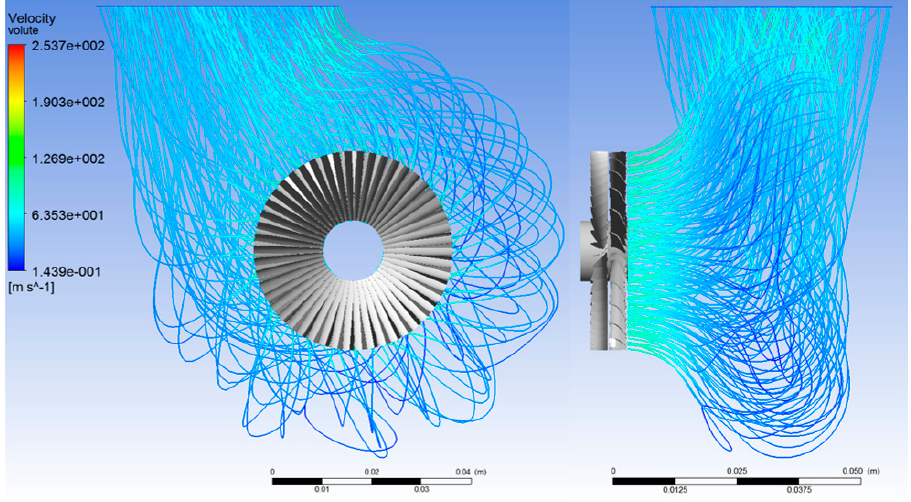
Figure 15. Optimised volute, velocity streamlines.